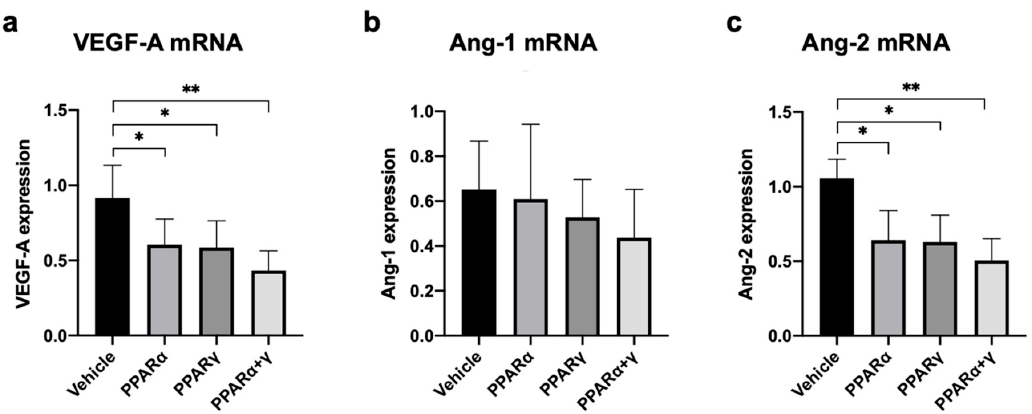
Figure 9. Expression of mRNA for molecules involved in neovascularization. Real-time RT–PCR analysis was performed to investigate the level of VEGF-A mRNA ( a ), Ang-1 mRNA ( b ), and Ang-2 mRNA ( c ) in the cornea at 6 h after alkali burn. Instillation of all PPAR agonists suppressed mRNA expression of VEGF-A ( a ). All PPAR treatments significantly reduced mRNA expression of Ang-2 at 6 h ( c ). In contrast, no significant differences were seen in the degree of Ang-1 mRNA expression between each group ( b ). The mRNA expression level of Ang-2 mRNA was relatively higher than that of Ang-1 mRNA. Data are presented as the mean ± standard error ( n = 8 samples/group). ** p < 0.01, * p < 0.05.